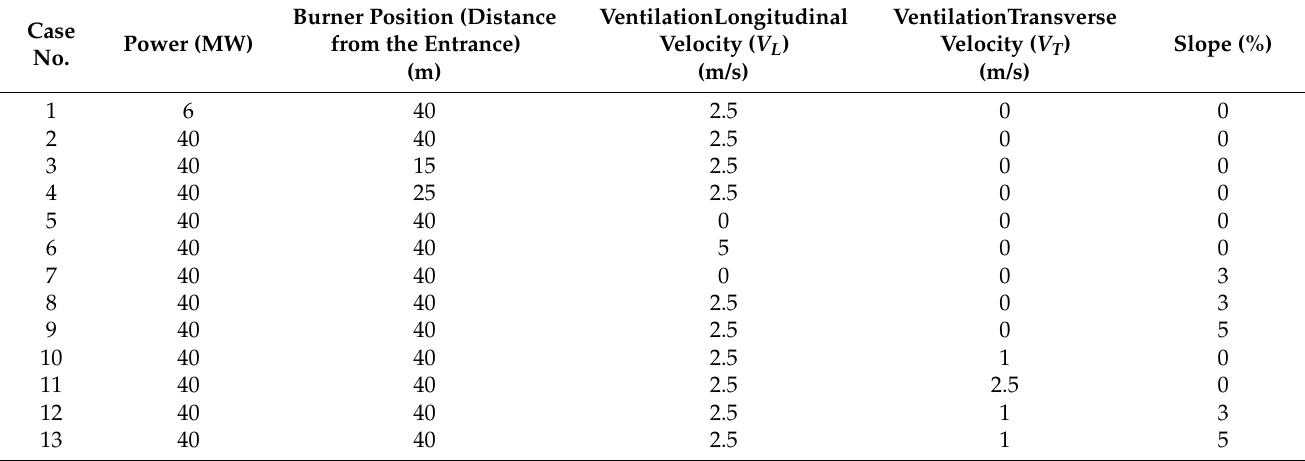
Table 1. A summary of